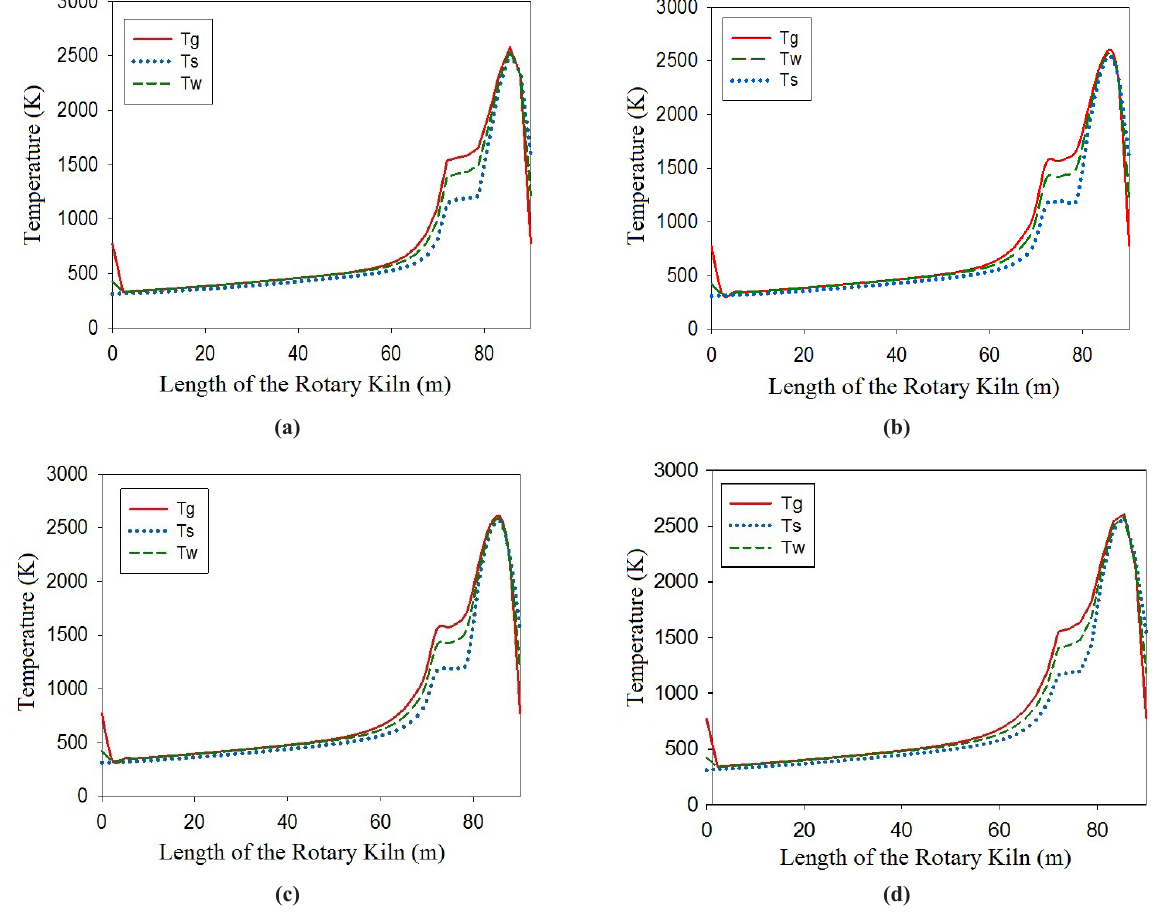
Figure 3 - Temperature profiles of the gas (Tg), the solid (Ts), and the wall (Tw) of the industrial rotary kiln at the steady state. ( a ) -20% of inlet gas speed; ( b ) -10% of inlet gas speed; ( c ) +10% of inlet gas speed; ( d ) +20% of inlet gas